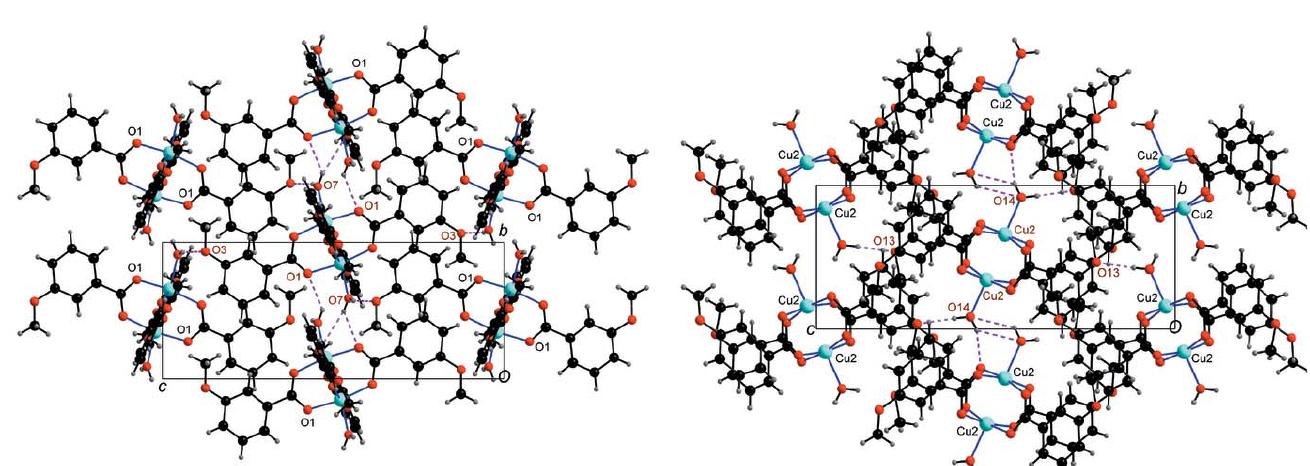
Figure 2 A view along [100] showing the O—H (cid:2)(cid:2)(cid:2) O hydrogen bonds (dashed lines) around the Cu1 dimer (left) and the Cu2 dimer (right).